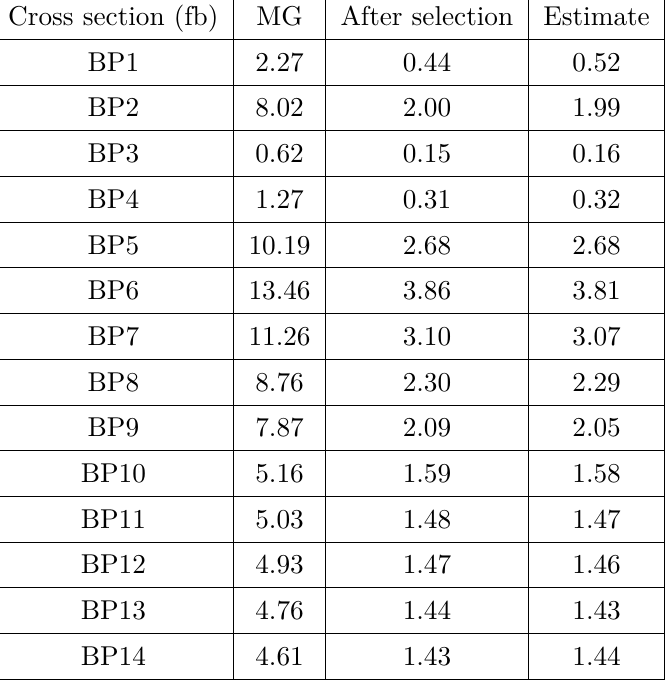
√ s = 14 TeV are given, after taking into